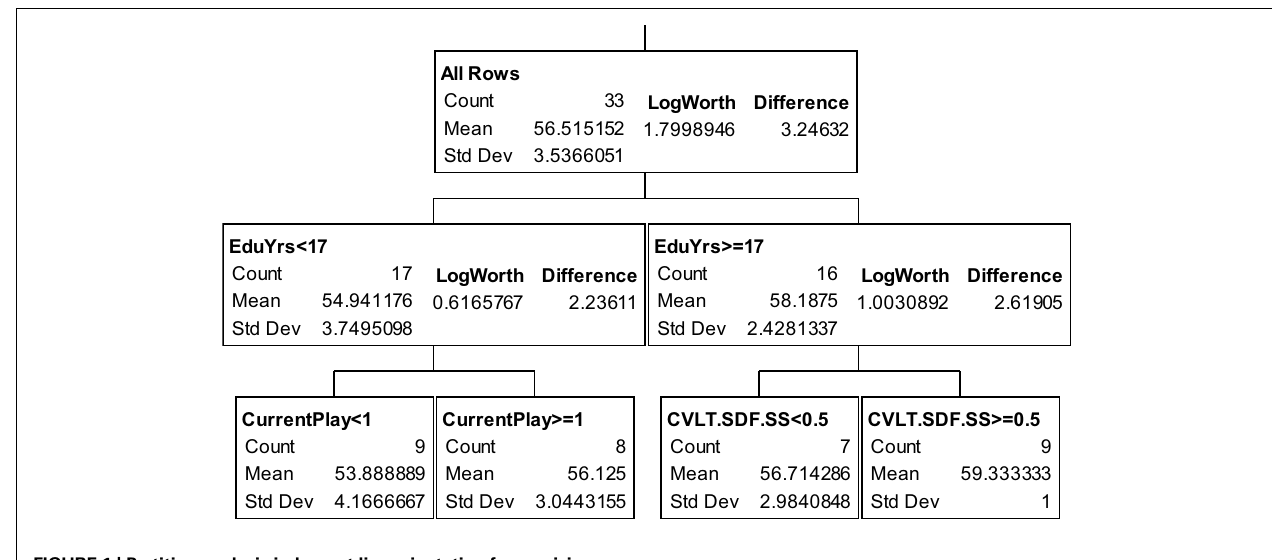
FIGURE 1 | Partition analysis judgment line orientation for musicians.